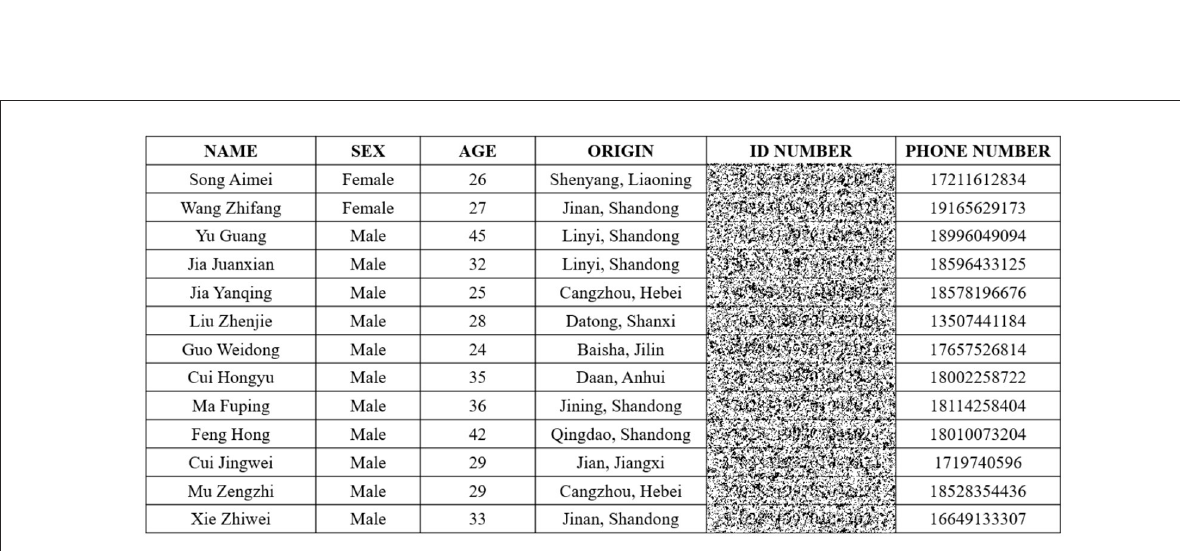
FIGURE15 Employee information diagram of a company. (Encrypted ID